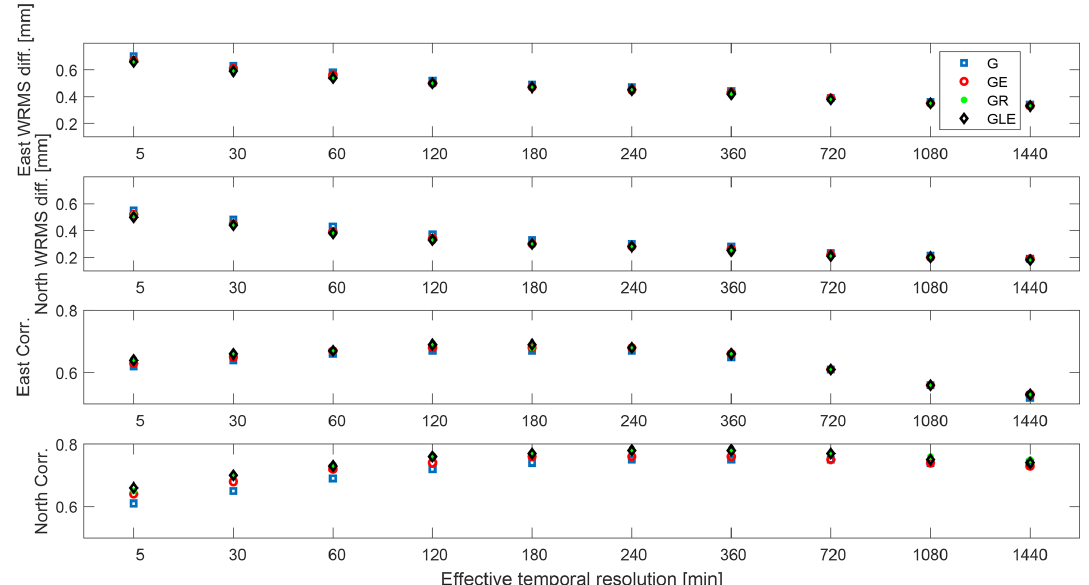
Figure 8. Correlations and WRMS differences between estimated gradients from the GNSS and the WVR data using different effective temporal resolutions, (cid:49)t eff